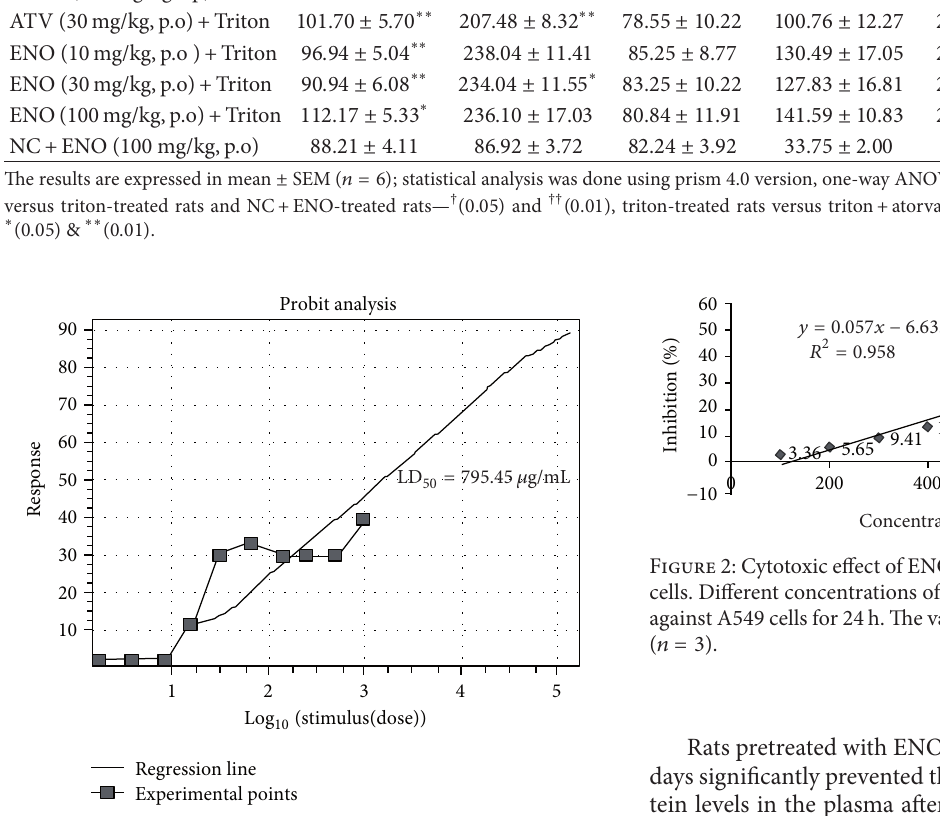
T 1: Effect of ENO and atorvastatin on total cholesterol and triglycerides in plasma of triton administered rats. T.cholesterol (mg/dL) Triglycerides (mg/dL) Treatments 6thhr 24thhr 48thhr 6thhr 24thhr 48thhr Normal Control (NC) Triton (250mg/kg,i.p)